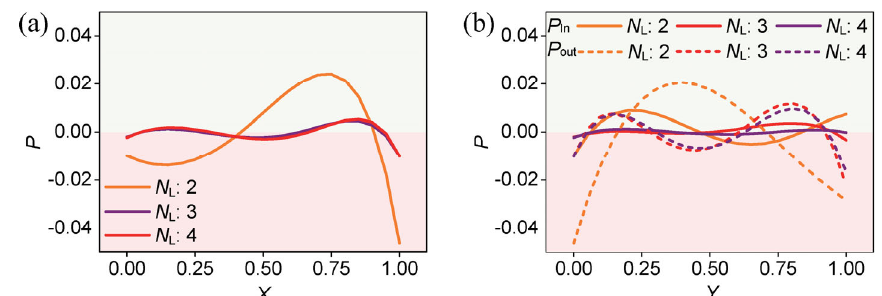
Fig. 8 Pressure distributions at the boundaries. (a) At the side edge. (b) At the inlet and outlet.